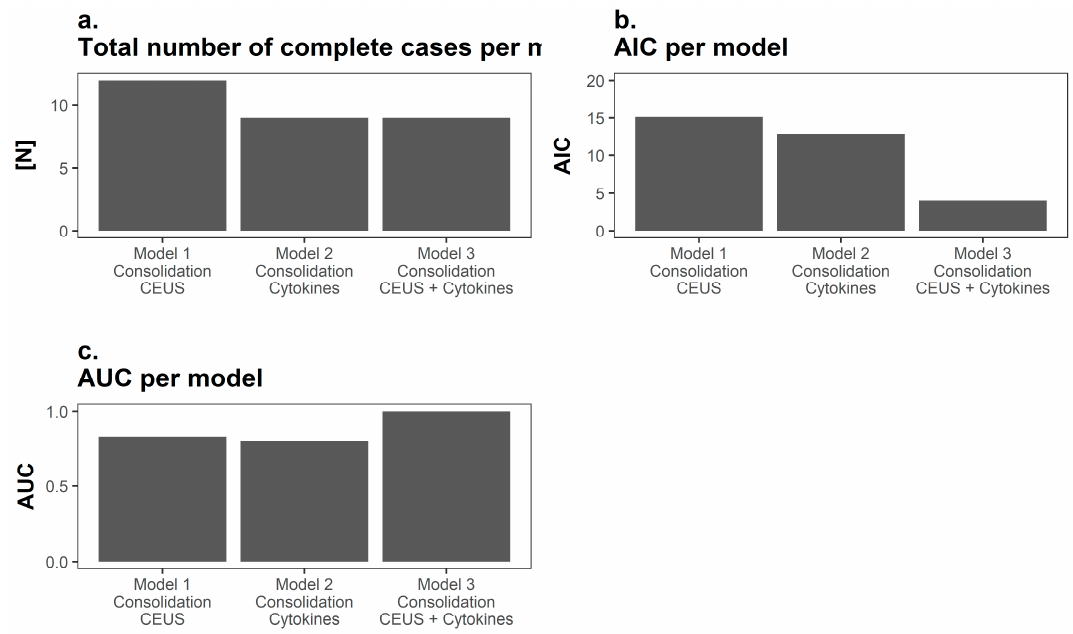
Figure 6. Visualization of the prognostic performance. ( a ) Only complete cases were included in the mathematical modelling process and due to single missing values analyzed cases were fewer once CEA was included; ( b ) Here the Akaike Information Criterion (AIC) is depicted for each respective model. Interestingly, despite fewer cases, the AIC was lowest in the mathematical model including parameters from both modalities (low AIC indicating better prognostic performance); ( c ) Similarly, the area under curve (AUC) was higher in the mathematical model including parameters from both modalities.